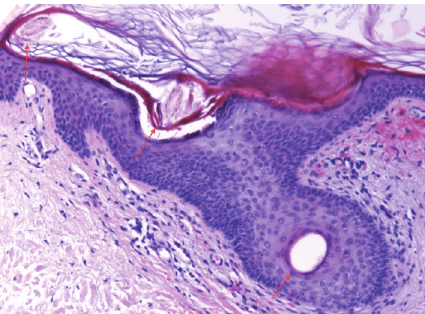
Figure 2: A punch biopsy from the right lower leg shows a sparse, perifollicular, lymphocytic infiltrate and extravasation of erythrocytes. There is hyperkeratosis of the slightly dilated follicular infundibulum. The two transverse sections of the intracorneal parts of a hair shaft (arrows) show the spiraling course of the hairs (cork screw appearance) characteristic of